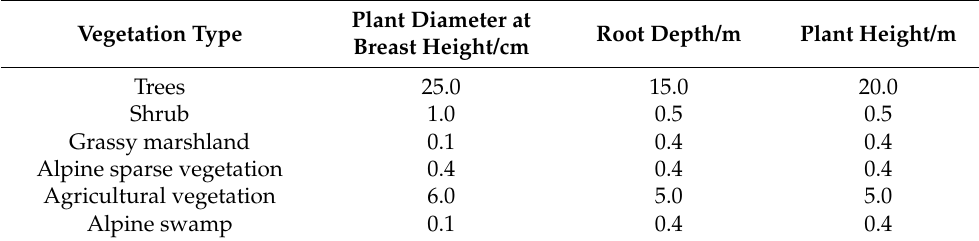
Table 2. Morphological parameters of different vegetation types. Vegetation Type